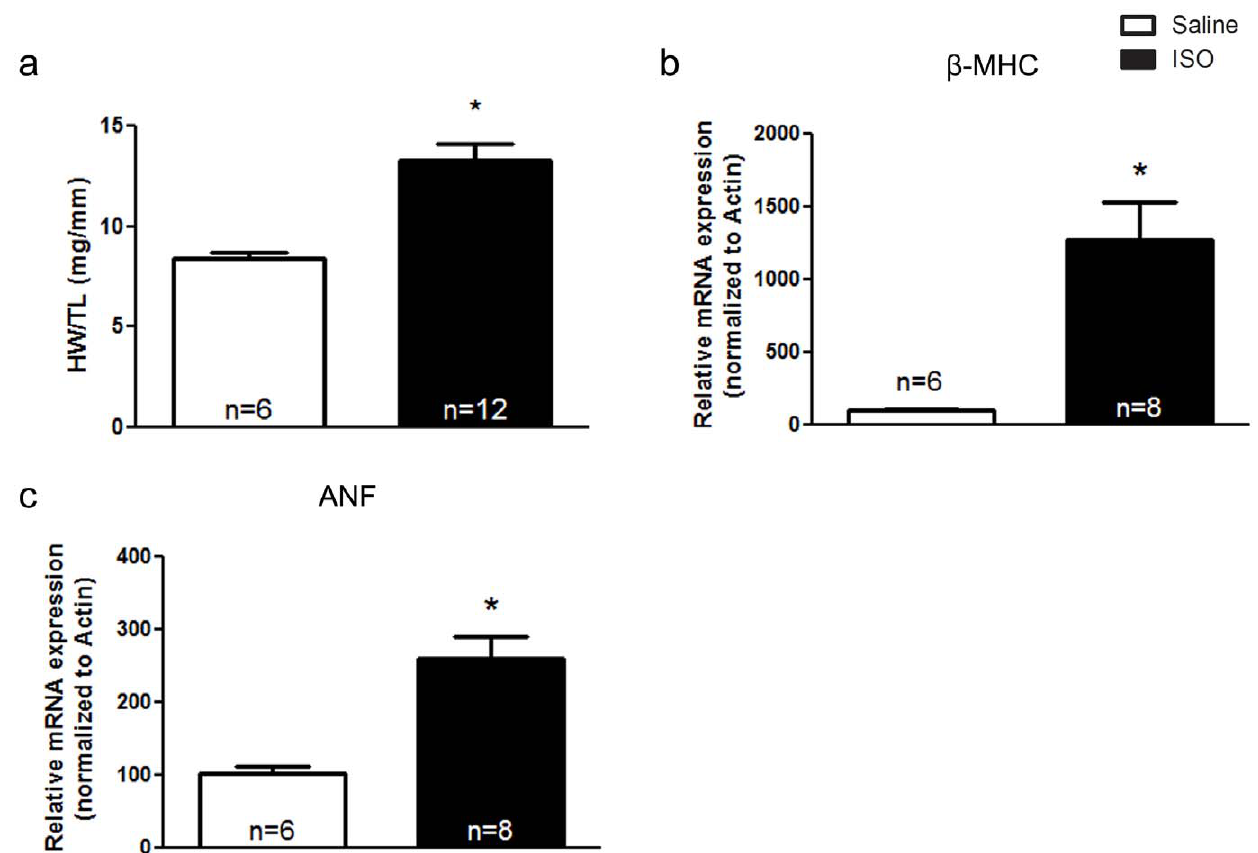
Figure 6. Chronic treatment with isoproterenol (ISO)-induces cardiac remodeling in wild-type mice. Two week ISO treatment led to a significant increase in heart weight/tibia length ratio as compared to saline-treated control mice ( panel a ). The expression of b -myosin heavy chain ( b -MHC, panel b ) and atrial natriuretic factor (ANF, panel c ) were significantly upregulated in ISO-treated mice. Data represent the mean 6 SEM, with n indicated within bars. *p , 0.05 versus wild-type mice.